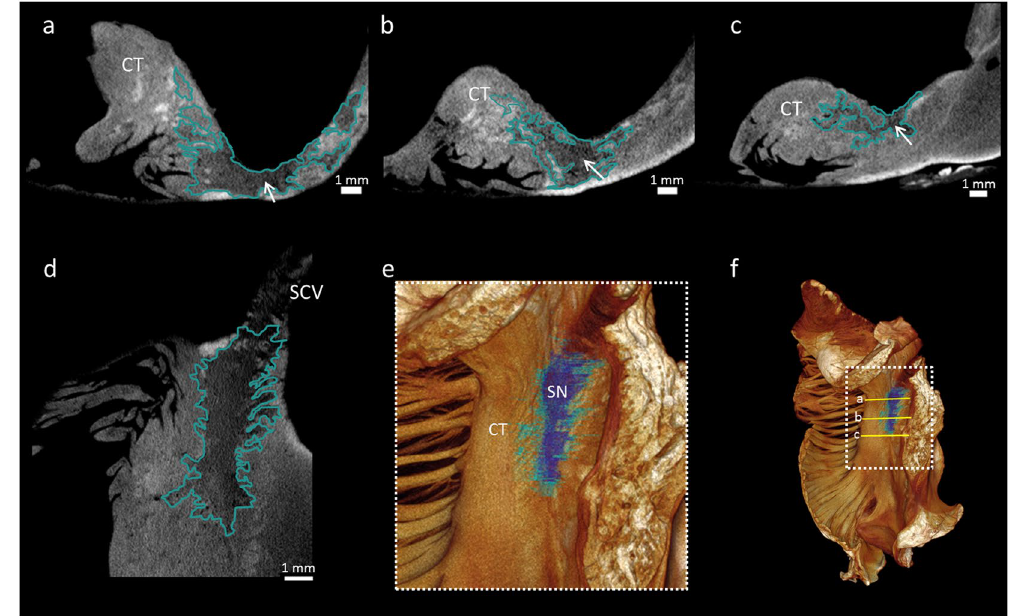
Figure 2. Objective segmentation of the human sinus node and its paranodal area. This figure demonstrates high resolution (28 × 28 × 28 µ m 3 ) micro-CT data from part of the right atrium containing the sinus node. The extent of the sinus node and its paranodal area is outlined in short-axis ( a – c ) and long-axis ( d ) micro-CT images. ( e ) Volume rendering (endocardial view) showing objective segmentation of the low pixel values corresponding to the body of the sinus node in dark blue; pixel values corresponding to the paranodal area are shown in turquoise. The plane of section in a-c is shown on the 3D volume rendering ( f ). Arrows indicate the approximate seed point for the objective segmentation of the sinus node. Sinus node body length = 14.8mm, width = 4.3mm. The sections are available to view without the outlines in the supplementary Fig. S2. CT- terminal crest, SN- sinus